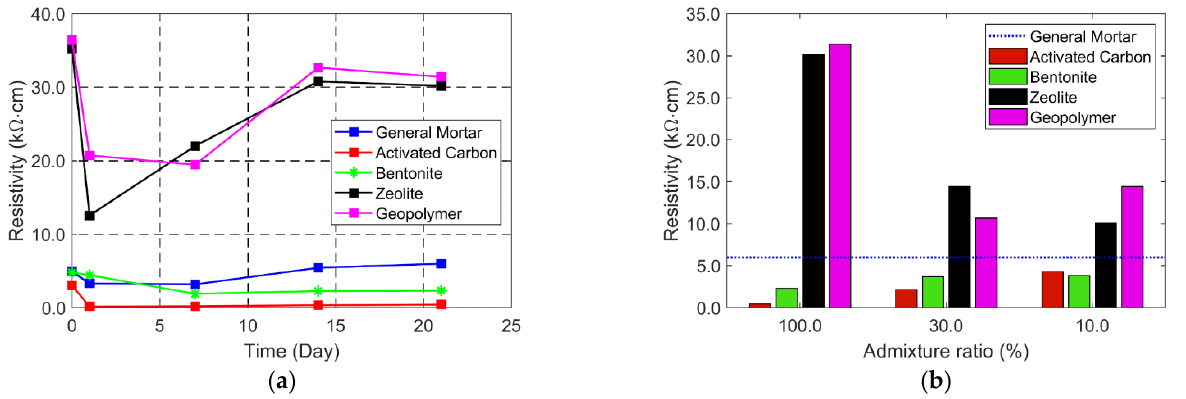
Figure 4. Resistivity variation during the 21 days after mortar specimens were immersed for 24 h (an admixture ratio of 100% for conductive mortars) ( a ) and resistivity after 21 days at different admixture ratios ( b ).